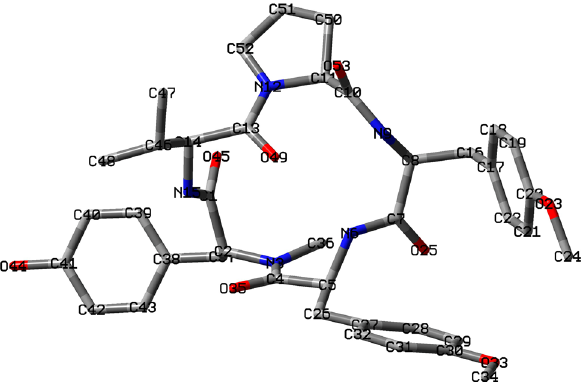
Figure 6. Schematic representation of Aspergillipeptide D showing the labels for the atom types and